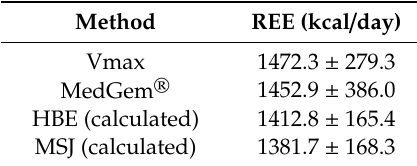
Table 2. Measured REE using four methods in 14